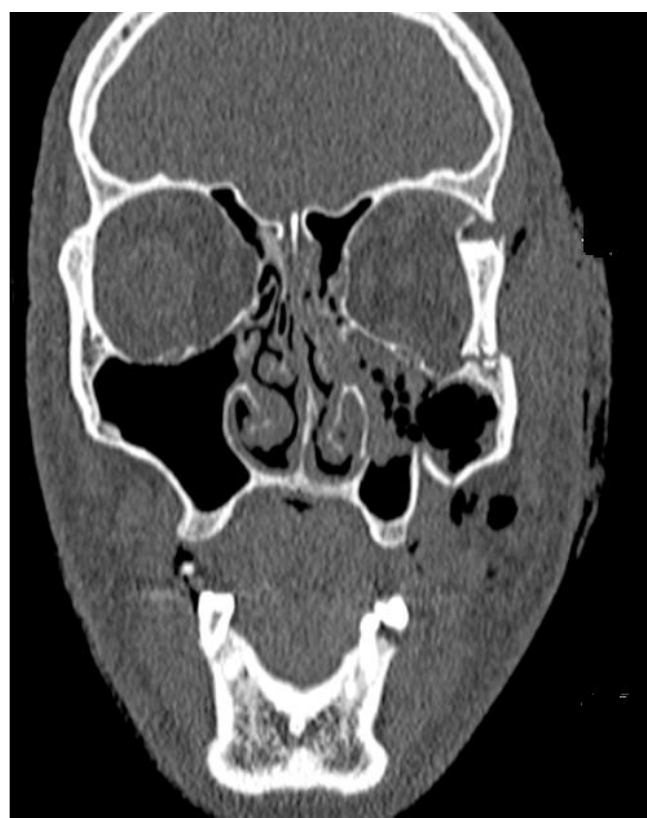
Figure 10. Trauma CT in frontal view with visible medially displaced entire lateral orbital wall of the left eye socket and massive swelling of soft tissues. Displaced lateral walls cause a slight decrease in orbital socket volume; however, the globe remains in the same position without any exophthalmos.